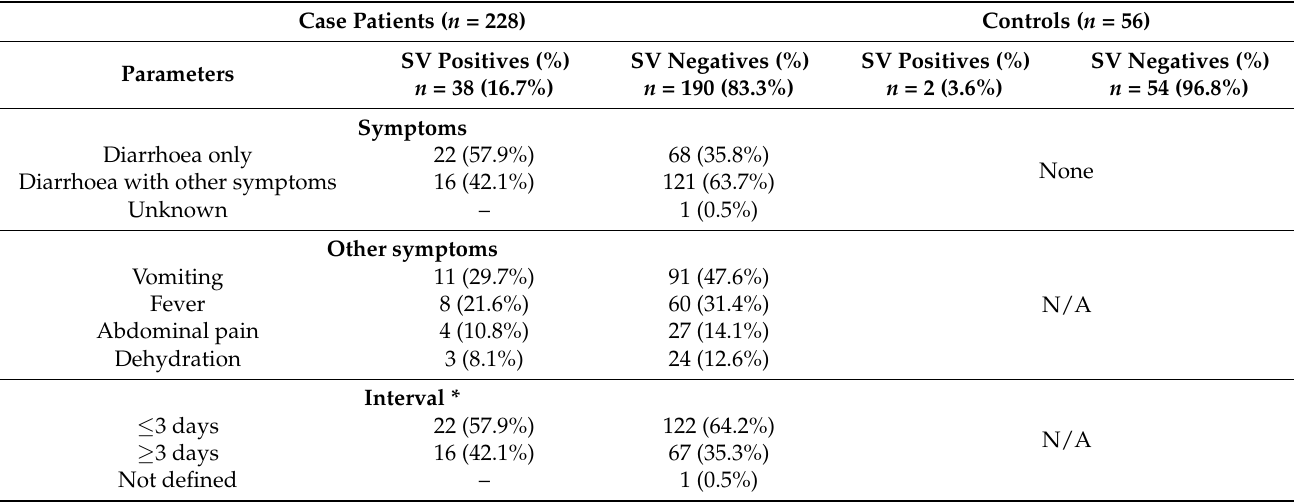
Table 2. Clinical features of study participant children under 5 years of age.